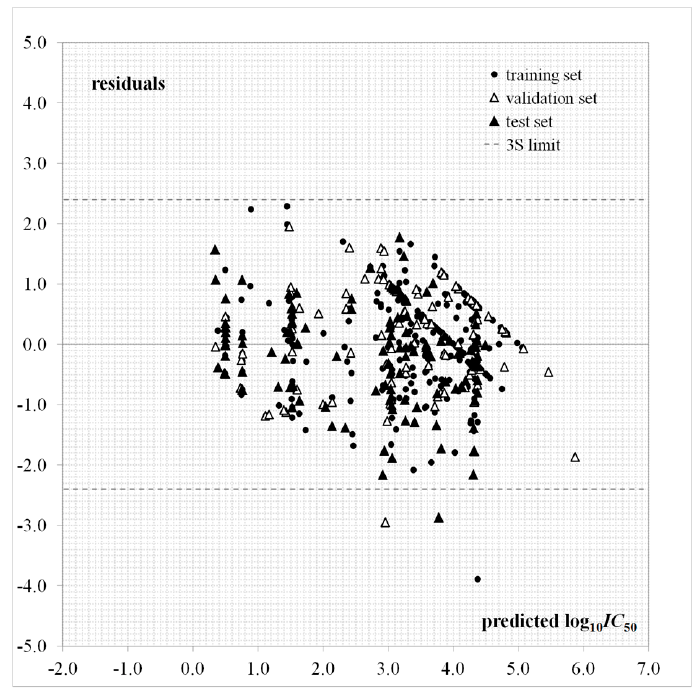
Figure 3. Dispersion plot of residuals for Equation (1).